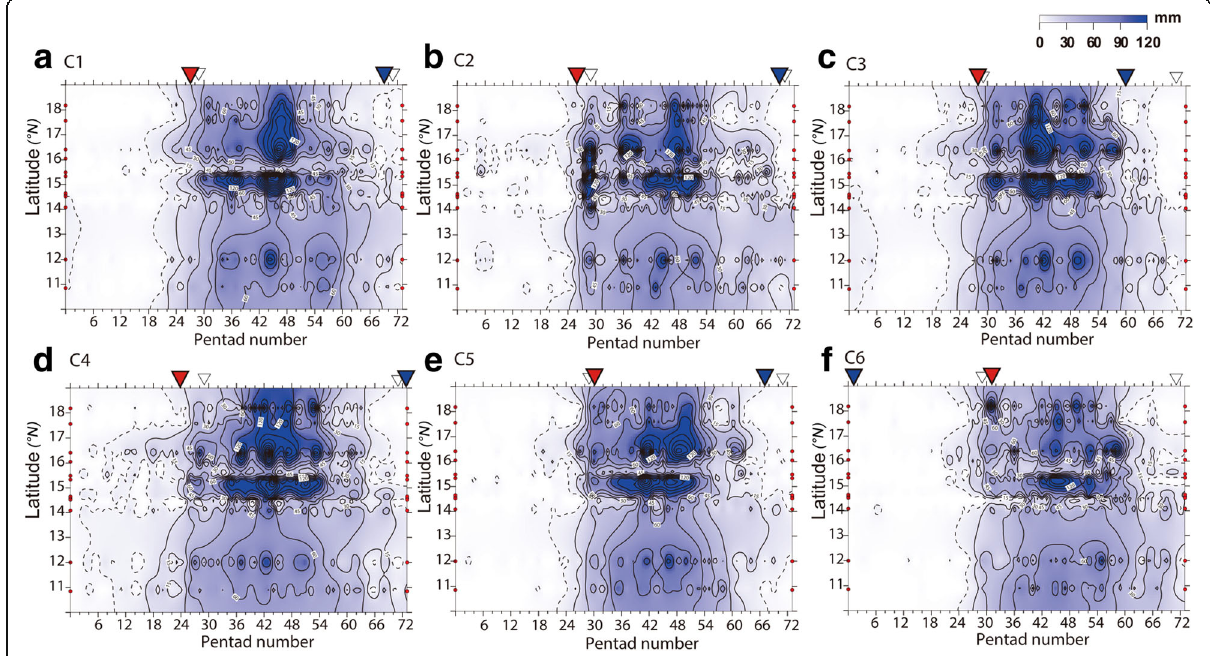
Fig. 4 a – f Time-latitude cross section of the pentad rainfall along the western coastal region in each cluster ( a C1, b C2, c C3, d C4, e C5 and f C6). The years used for the composite analyses are listed in Table 1. The red circles on the vertical lines correspond to the latitude of the observation stations shown in Fig. 1a as red cross marks. The red (blue) inverse triangles on the horizontal line indicate the first pentad when the sign of the time coefficients changed after (before) the 18th pentad from negative to positive (from positive to negative) for each cluster. The white inverse triangles indicate the same as Fig. 1b. The contour interval is 15 mm, and the dotted line indicates a contour of 5 mm